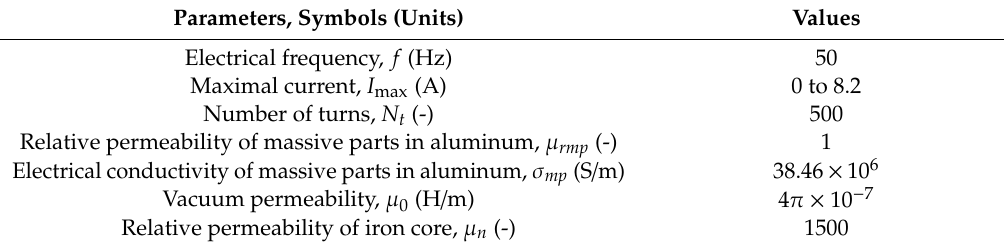
Table 2. Physical parameters.